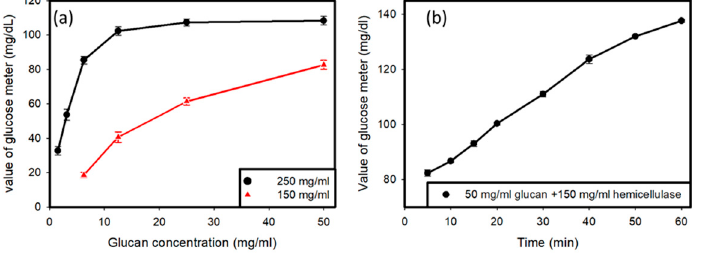
Figure 2. ( a ) Reading of the glucose meter versus the glucan concentration tested with different values of hemicellulase. ( b ) Reading of glucose meter over time with fixed values of glucan (50 mg/mL) and hemicellulase (150 mg/mL) .